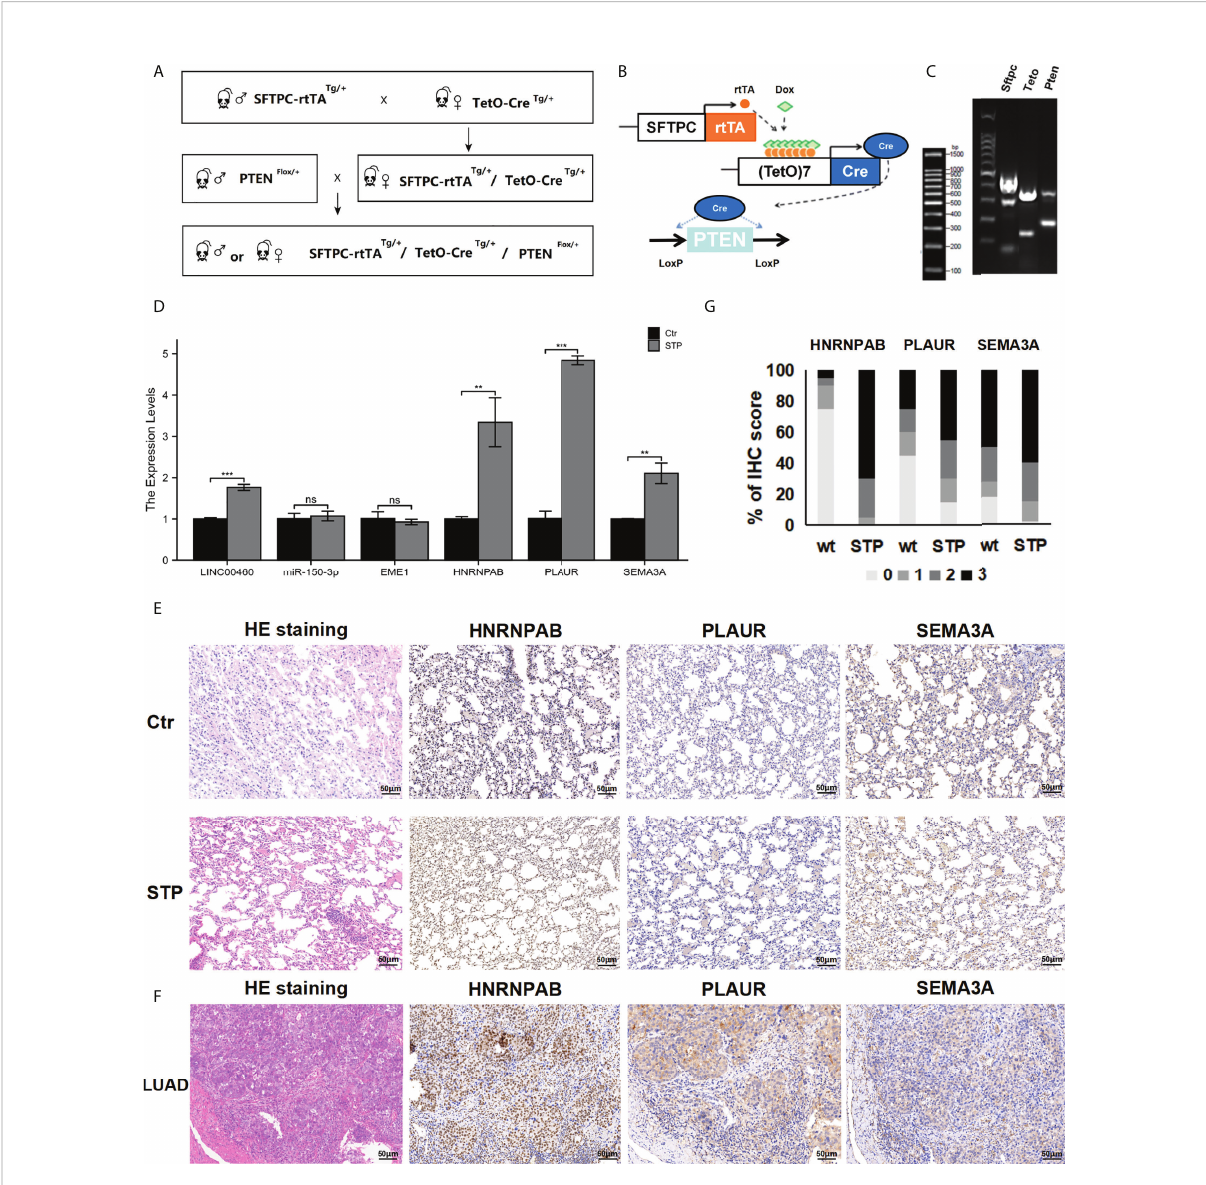
FIGURE 11 Expression of predicted target genes in lung tissue. (A, B) The construction of STP mouse model. (C) Genotyping results. (D) The expression of genes in PTEN-de fi cient lung tissues. (E) The HE and IHC staining results. (F) The expression of protein in PTEN-de fi cient lung tissues. (G) Percentage of malignant cells with different target genes IHC score in wt and STP groups. ns, no signi fi cant; *p < 0.05; **p < 0.01; ***p <